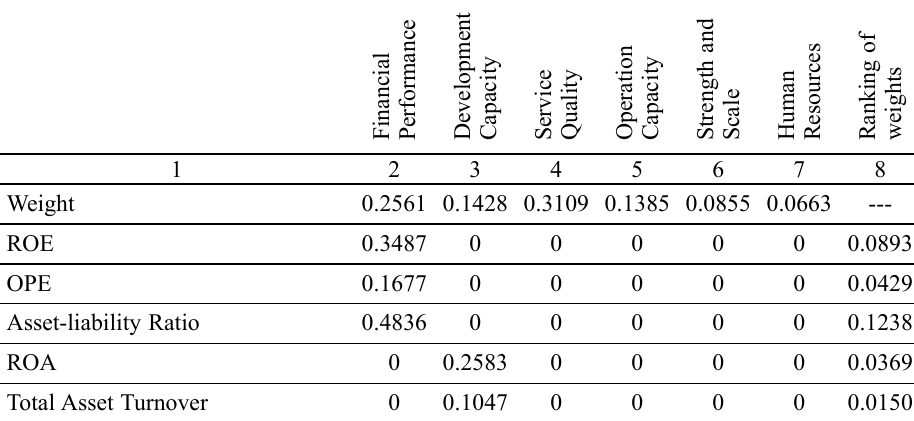
Table 10. Index and its weight distribution of the airline competitiveness